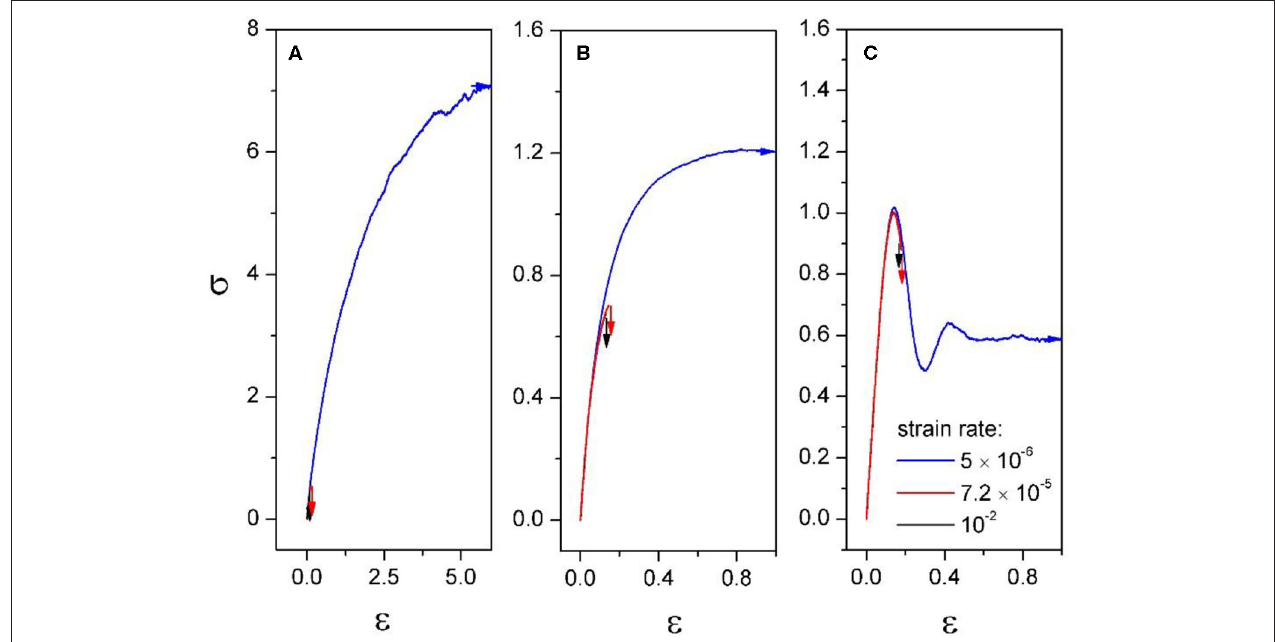
FIGURE 5 | FBM simulation results with varying shape factor k for the Weibull distributions of single fiber strength: (A) k = 0.5; (B) k = 1; and (C) k = 3. For each shape factor, stress–strain curves for three different strain rates (1 × 10 − 2 , 7.2 × 10 − 5 , and 5 × 10 − 6 s − 1 ) are given. The vertical arrows mark the point where the bundle fractures, while the horizontal arrows indicate that the bundle is still intact but the simulation was stopped. Reprinted from the Journal of Glaciology with permission of the International Glaciological Society [4].